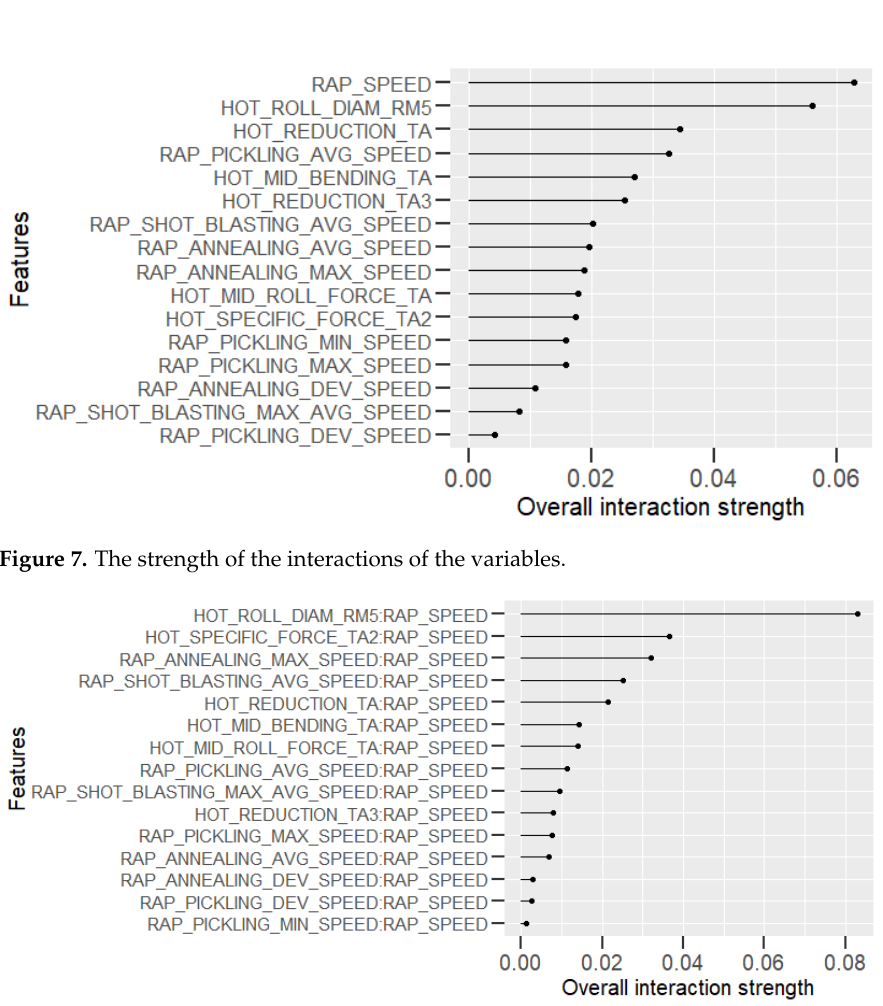
Figure 8. Interaction between the most important variable and other